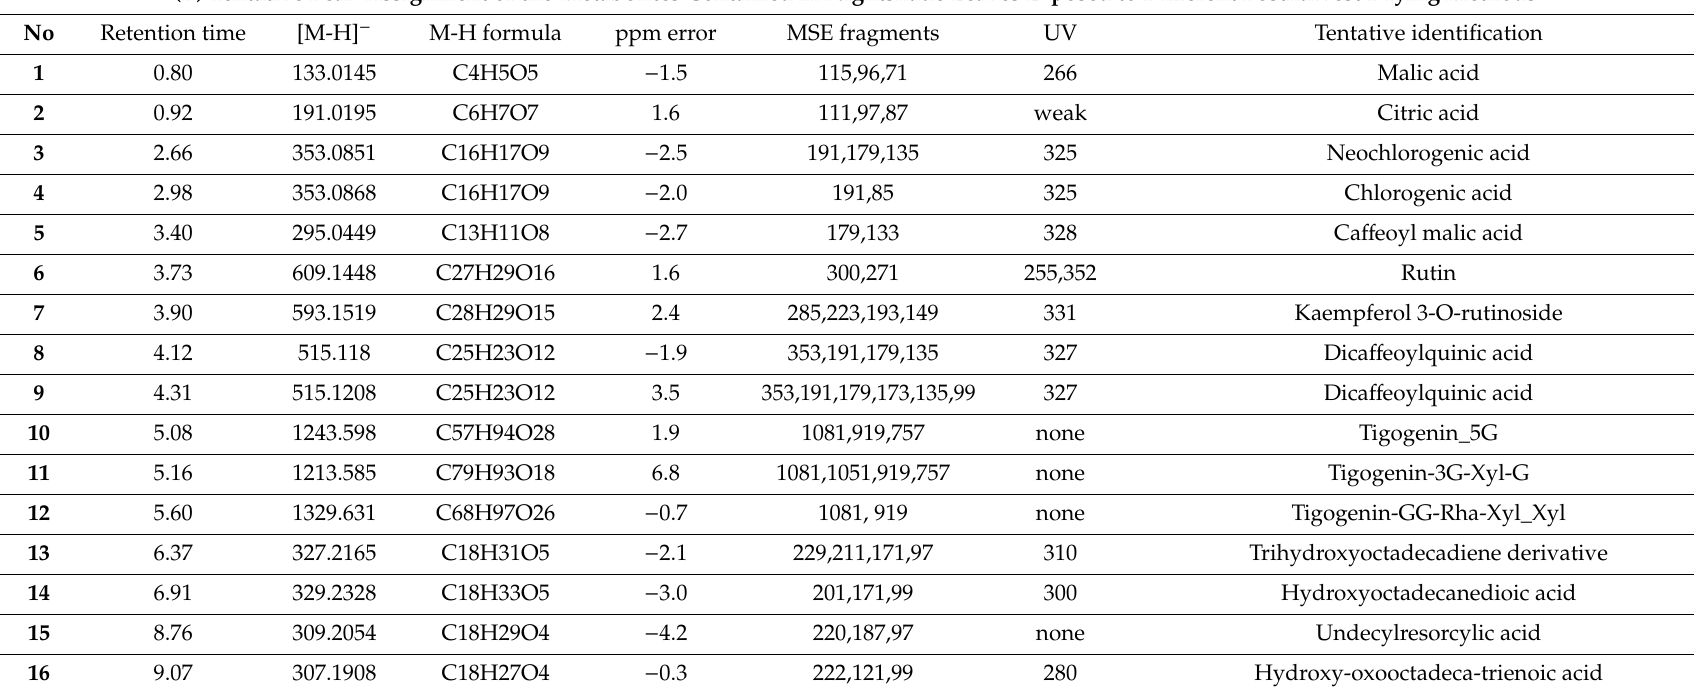
(B) Tentative Peak Assignment of the Metabolites Contained in Nightshade Leaves Exposed to Di ff erent Postharvest Drying